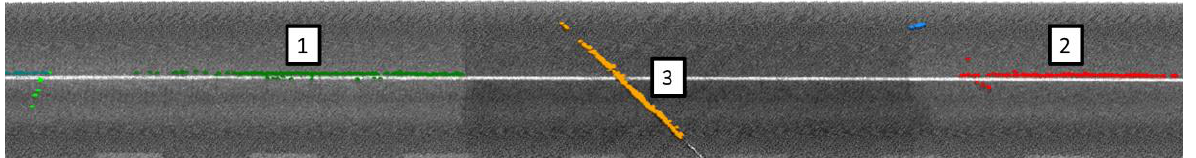
Figure 18. Road spot 4. Ladybug camera image with delimited cracked areas.